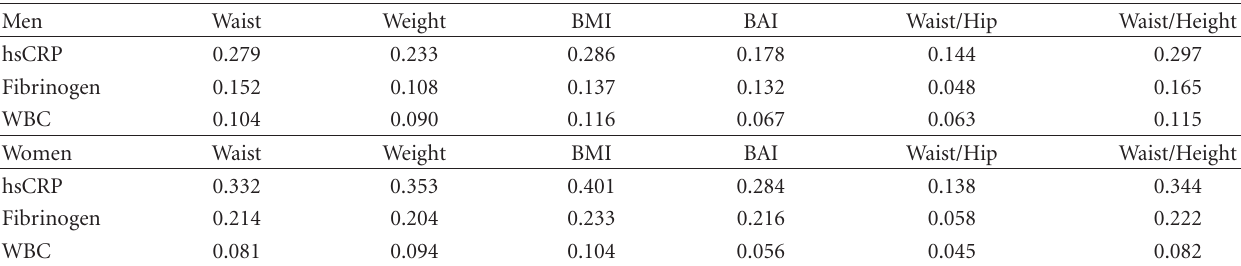
Table 5: Partial correlation between the di ff erent anthropometric measurements and the di ff erent inflammatory variables in the linear regression models ∗ after adjustment for many possible risk factors and medications ‡